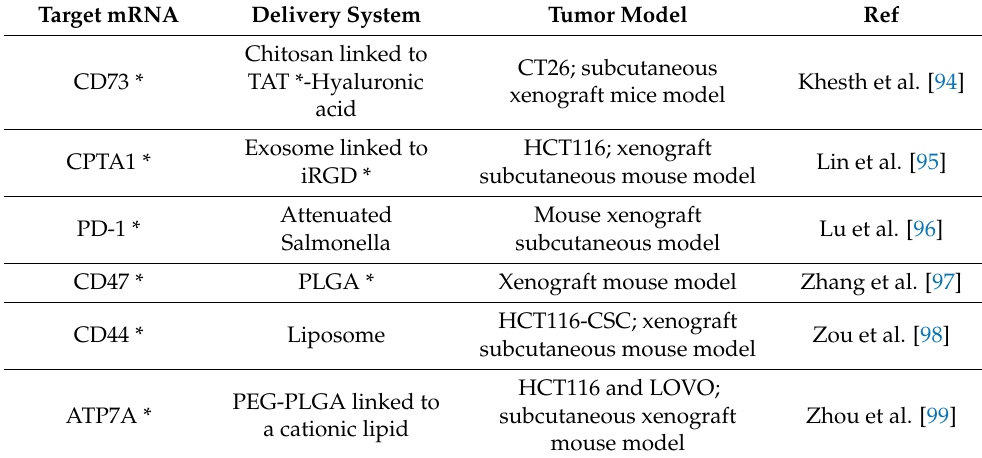
Table 6. siRNA employment in colorectal